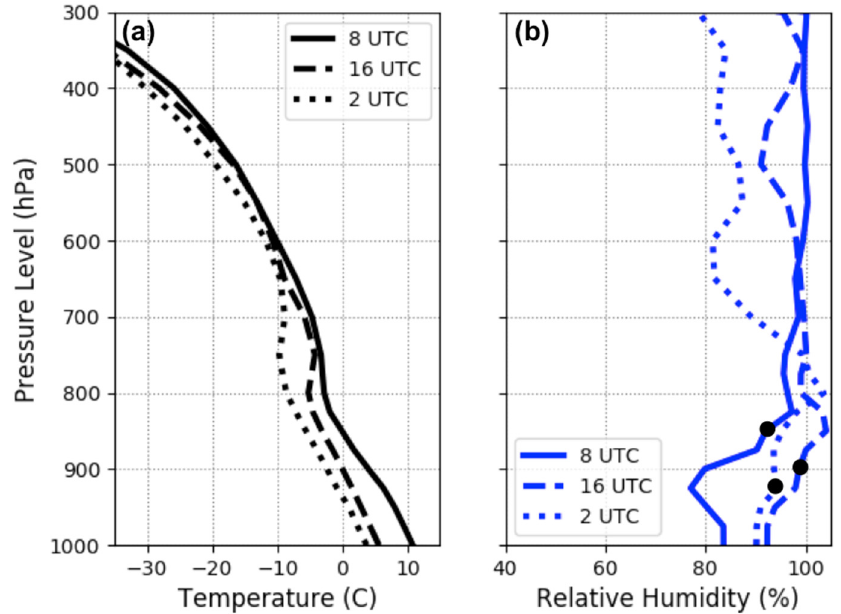
Figure 12. Profiles of temperature ( a ) and relative humidity ( b ) from the ERA5 reanalysis for 24 October 2017 0800 UTC (solid lines) and 1600 UTC (dashed lines), and 25 October 2017 0200 UTC (dotted lines). The black dots in panel b signify the 0 °C level for the profiles.